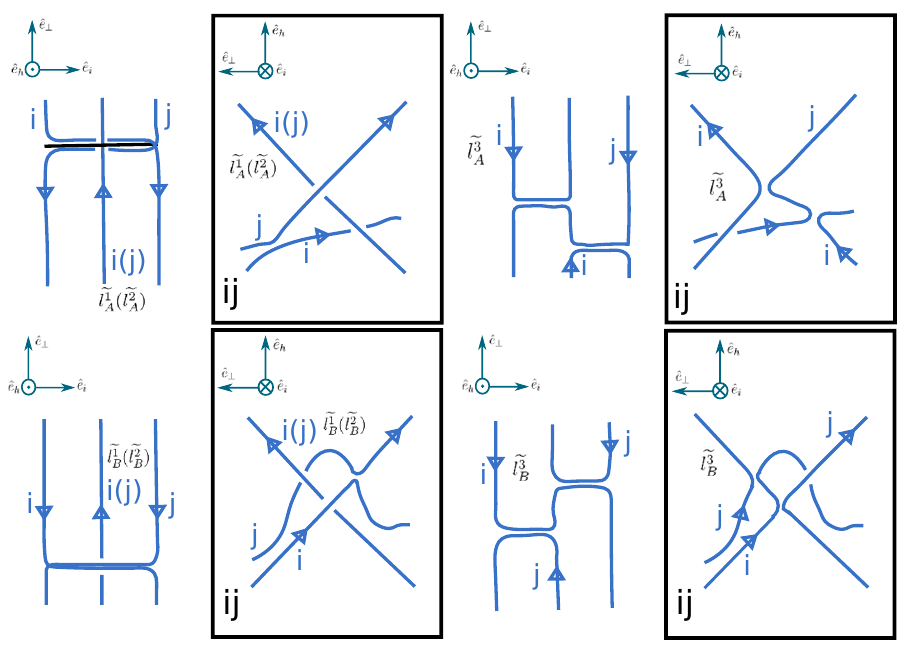
Figure 55 . Three lifts of l A and l B